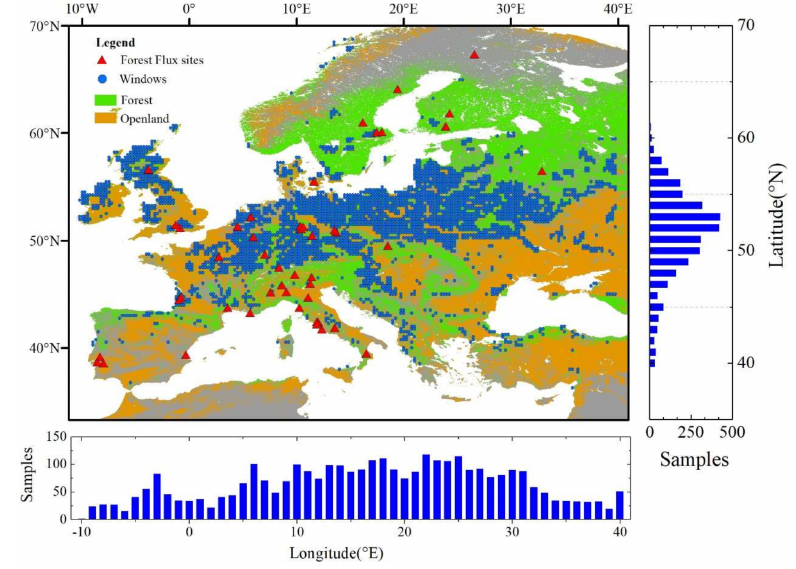
Figure 1. The spatial distributions of land cover types, paired sites and selected windows. The green and orange backgrounds refer to areas with forests and open lands, respectively. The paired sites are marked with red triangles. The blue points refer to the selected windows (0.4 × 0.4 ◦ ), which have areas with more than 10% of forests and open land. The small panels in the below and right show the sample window numbers at each 1 ◦ (longitude and latitude)